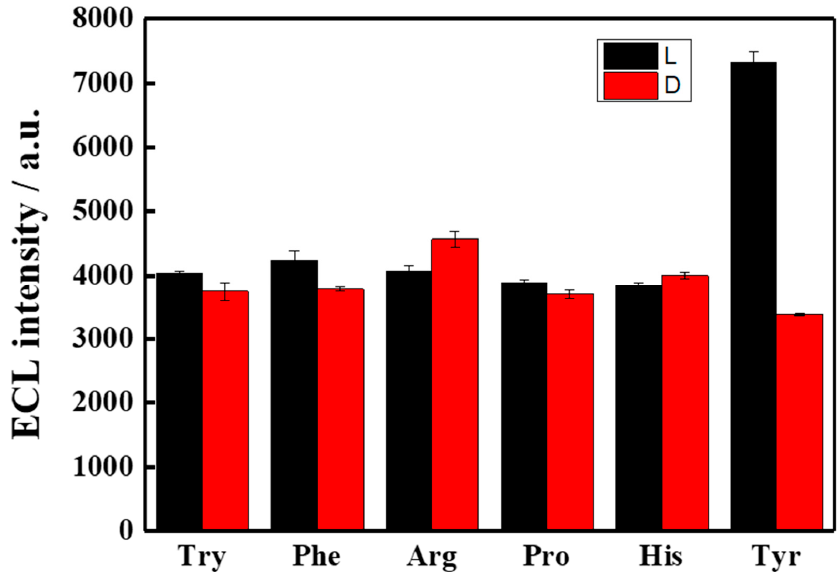
Figure 11. ECL responses for the discrimination of different amino acid